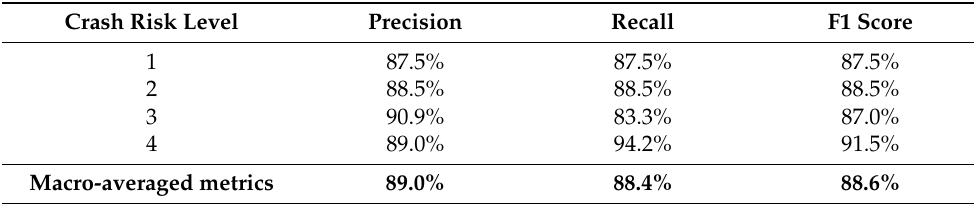
Figure 4. Confusion Matrix for the test dataset. Table 5. Performance evaluation metrics for each crash risk level.